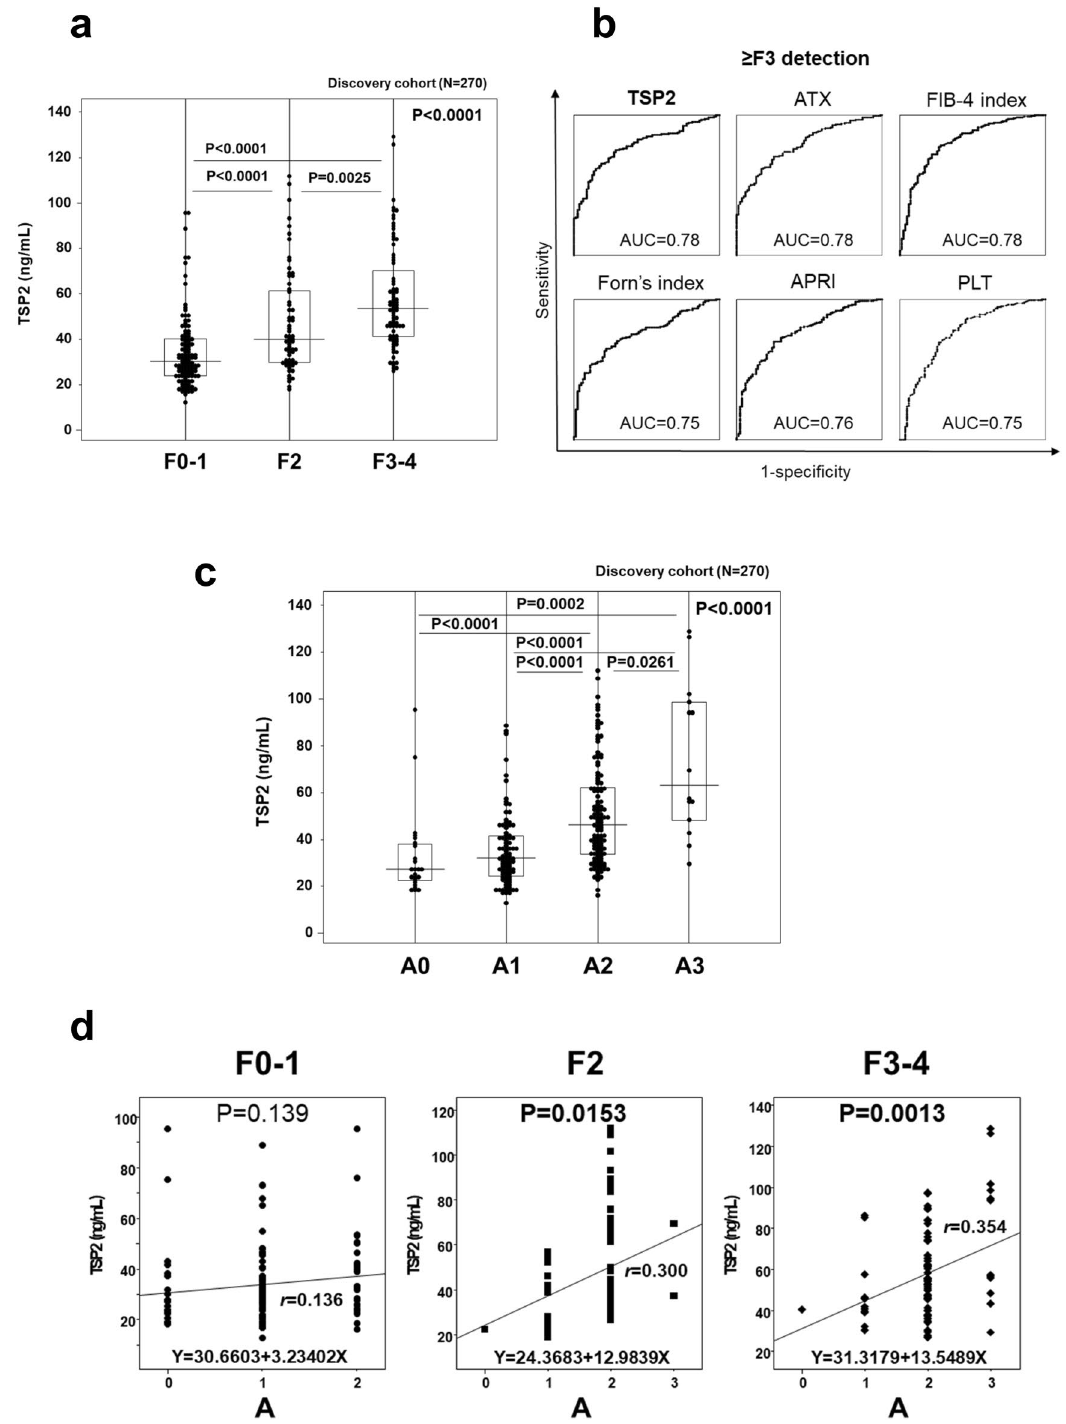
Figure 1. Positive correlation between serum TSP2 levels and fibrosis stage/activity grade in HCV-infected patients in the discovery cohort. ( a ) Correlation of serum TSP2 levels and fibrosis stage. ( b ) AUC values for estimating severe fibrosis stage (≥ F3). ( c ) Correlation of serum TSP2 levels and activity grade. ( d ) Correlation of serum TSP2 levels and activity grade at different fibrosis stages. Data were obtained from 270 cases in the discovery cohort. A activity grade, APRI aspartate aminotransferase to platelet ratio index, ATX autotaxin, AUC area under the receiver operating characteristic curve, F fibrosis stage, FIB-4 index fibrosis-4 index, PLT platelet count, TSP2 thrombospondin